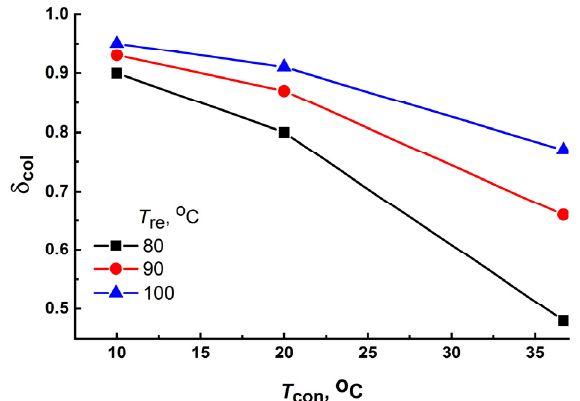
Figure 12. Effect of the condensation temperature on the water-collection fraction δ col of the AWHA system based on MIL-160 during the dry season (July) for the Riyadh-Old region.